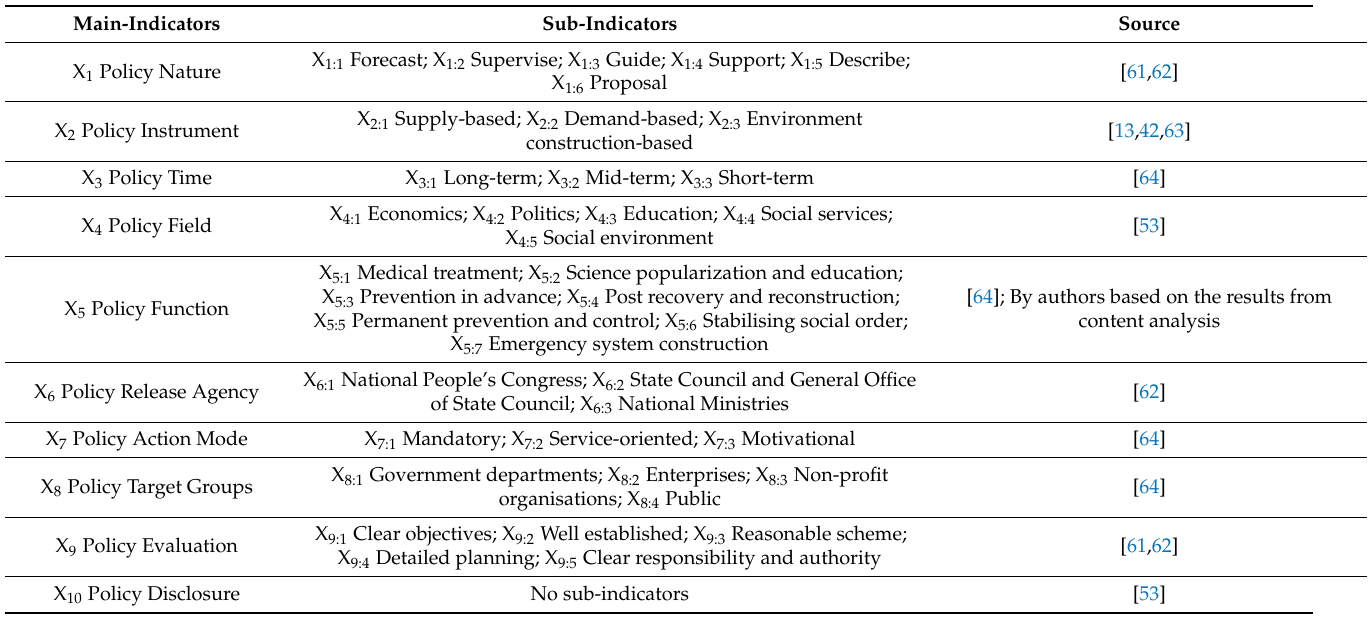
Table 1. Main and sub